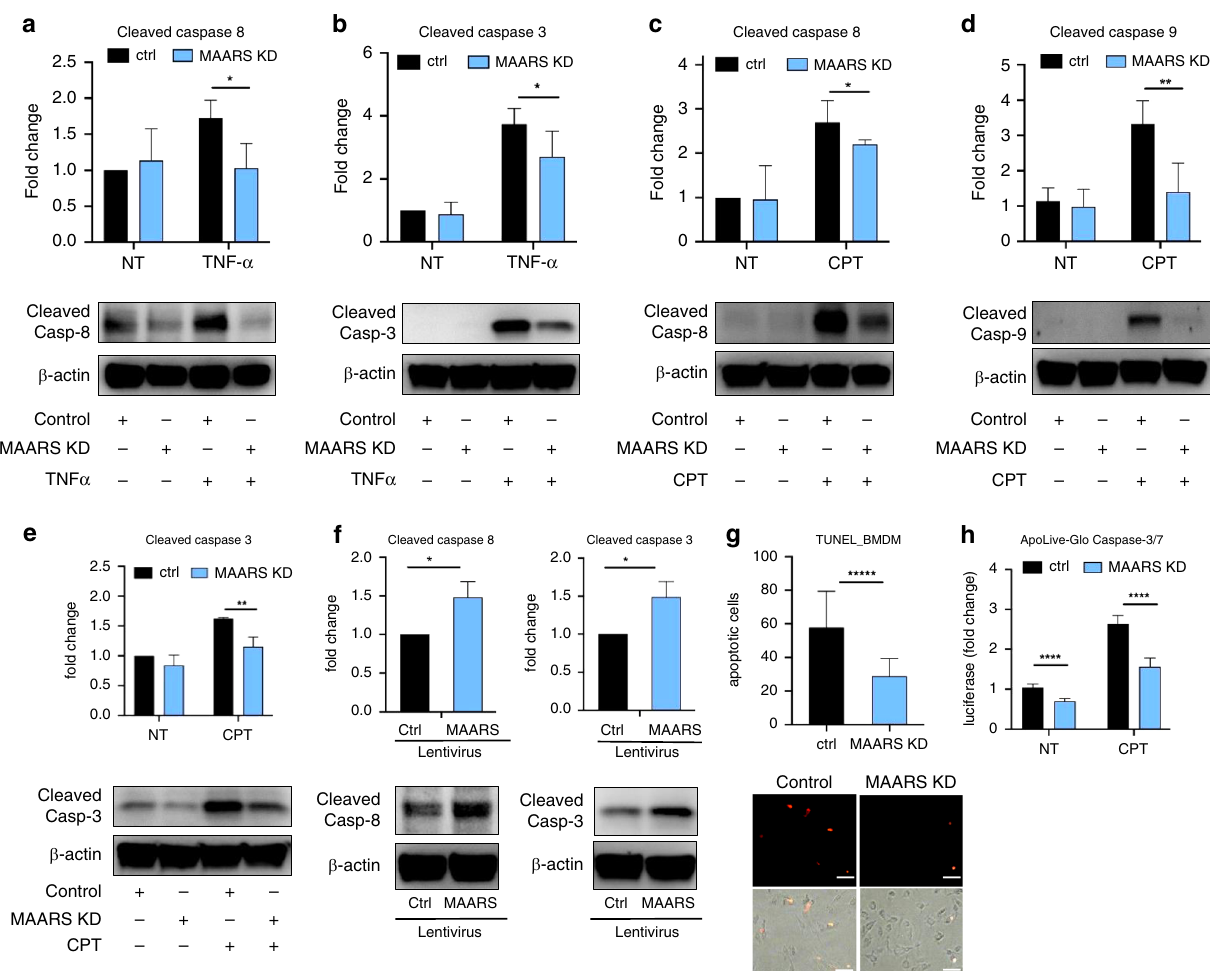
Fig. 3 MAARS knockdown decreases macrophage apoptosis. Western blot quanti fi cation of cleaved caspase-8 ( a ) and cleaved caspase-3 ( b) lysate from BMDMs transfected with MAARS -speci fi c or control gapmeRs, and activated with TNF-alpha (50 ng ml − 1 ) for 18 h ( n = 4). Western blot quanti fi cation of cleaved caspase-8 ( c ), cleaved caspase-9 ( d ), and cleaved caspase-3 ( e ) from lysates of BMDMs transfected with MAARS -speci fi c or control gapmeRs, and activated for 2 h with 20 µ M camptothecin (CPT; n = 3). f Cleaved caspase-3 and -8 expression in BMDMs transduced with lentivirus control or overexpressing MAARS ( n = 3). g In vitro TUNEL staining of BMDMs transfected with MAARS -speci fi c and control gapmeRs and activated with 20 µ M CPT ( n = 3; 25 images quanti fi ed per condition). h Quanti fi cation of apoLiveGlo cleaved caspase-3/7 enzymatic assay of BMDMs transfected with MAARS - speci fi c and control gapmeRs and activated with or without CPT (20 µ M) ( n = 3) For all panels, values are mean ± SD; * p < 0.05; ** p < 0.01; *** p < 0.001; **** p < 0.0001; ***** p <